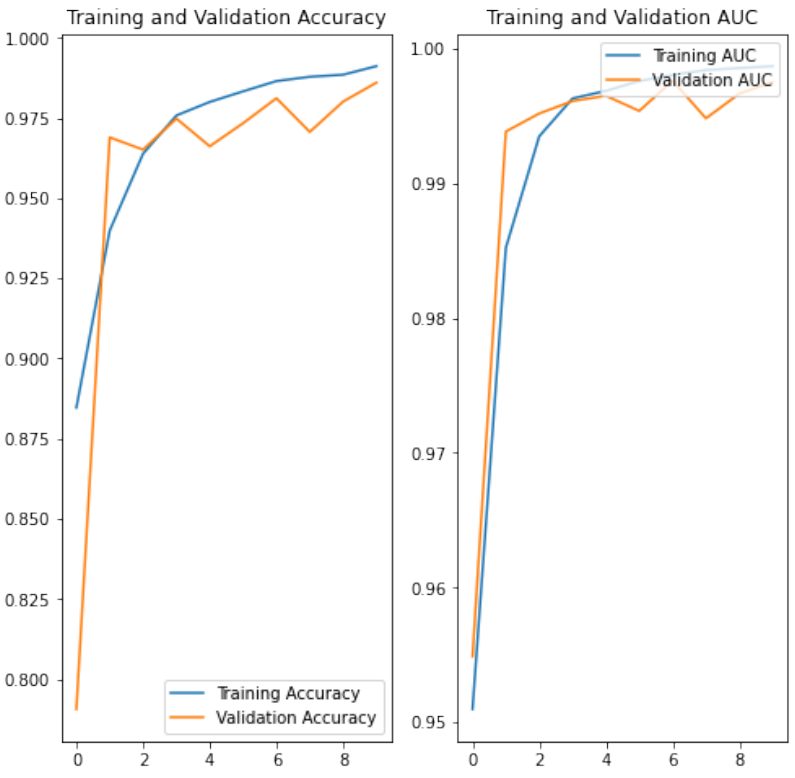
Figure 6. Validation accuracy and Validation AUC ROC in Coco+ILSVR(205K)+F5 & Model 2 & LSB, LSB Random,